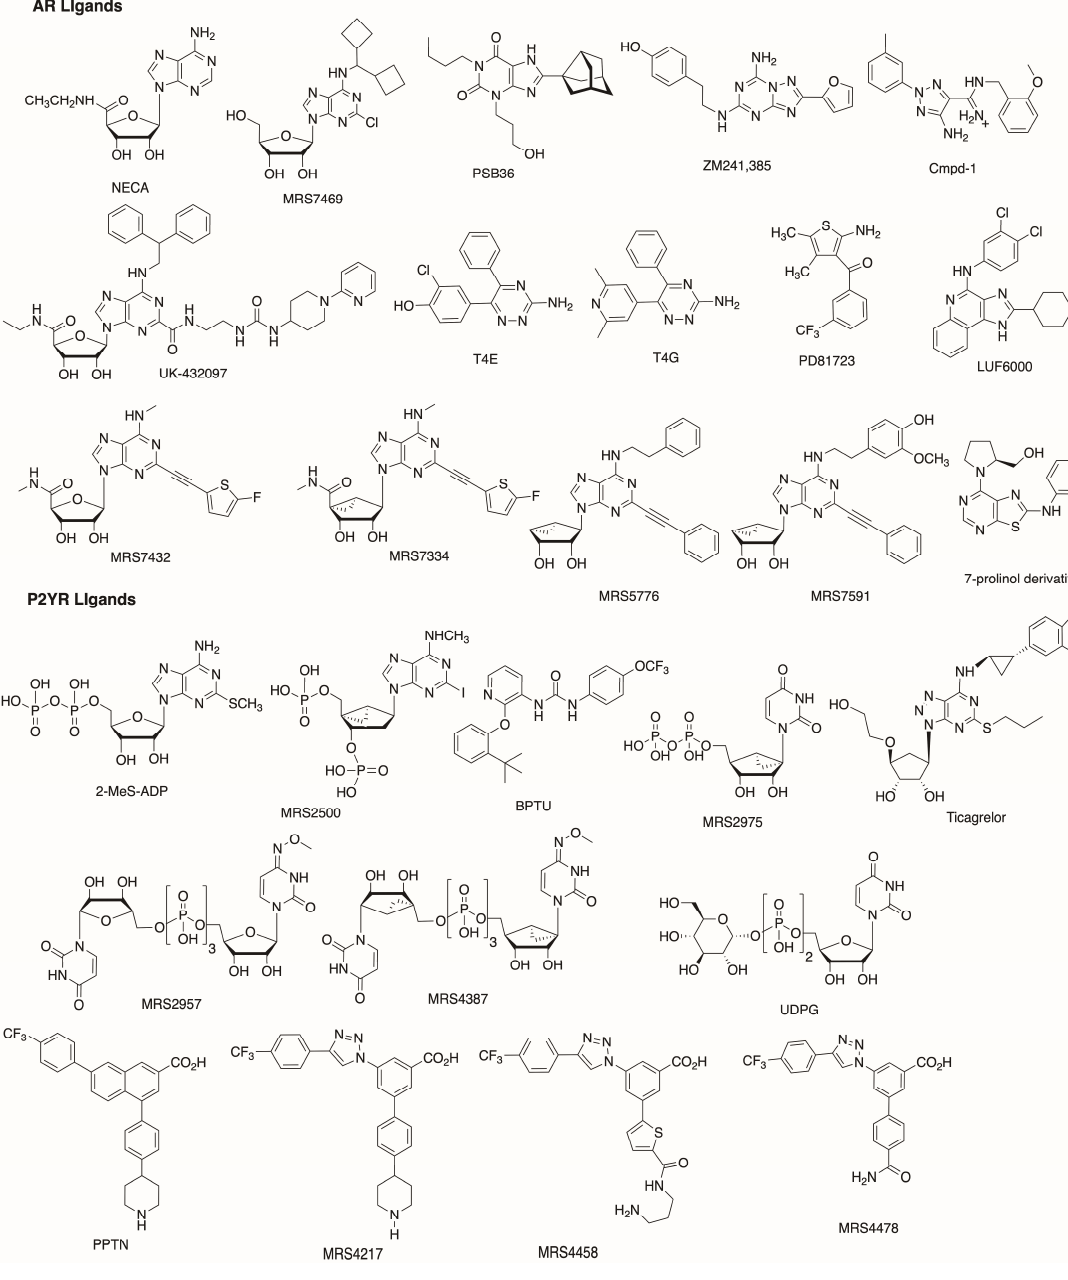
Figure 1. Structures of ARs and P2YRs (both orthosteric and allosteric) ligands discussed.